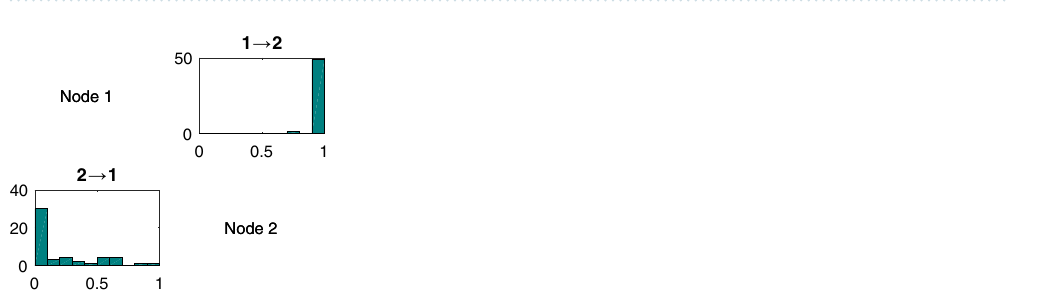
Figure 1. Different network structures and their corresponding adjacency matrices. Going from left to right from the first column to the seventh, we have the 2-species, 3-fan out, 3-fan in, 5-linear, 5-nonlinear, 34-Zachary1 and 34-Zachary2 networks. Generated with MATLAB R2016a 40 .